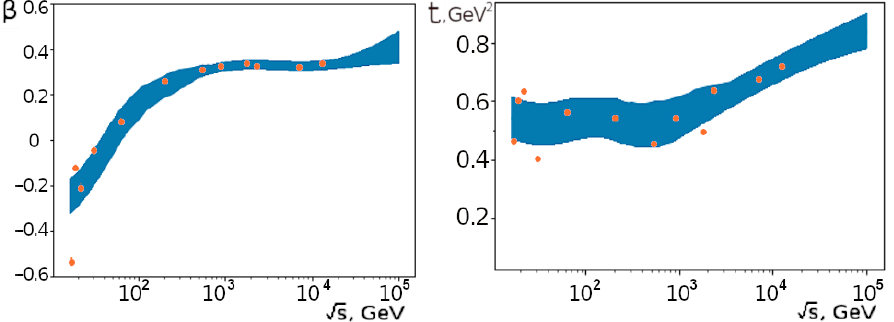
Figure 10. Approximation of the dependence of the parameters of the model ( β , t ) on the collision √ s , GeV) using the Gaussian process. Dots show the most probable values of the parameters energy ( extracted from the datasets at fixed energy. The shaded area shows the one standard deviation